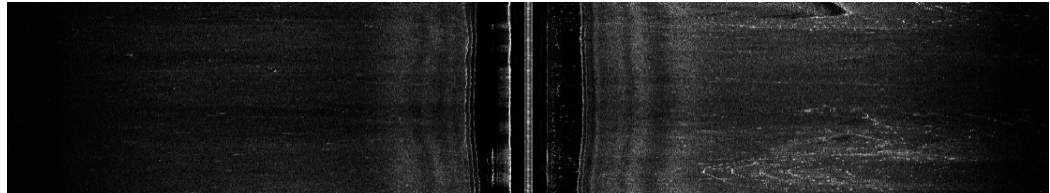
Figure 4. Examples of the raw SSS images.